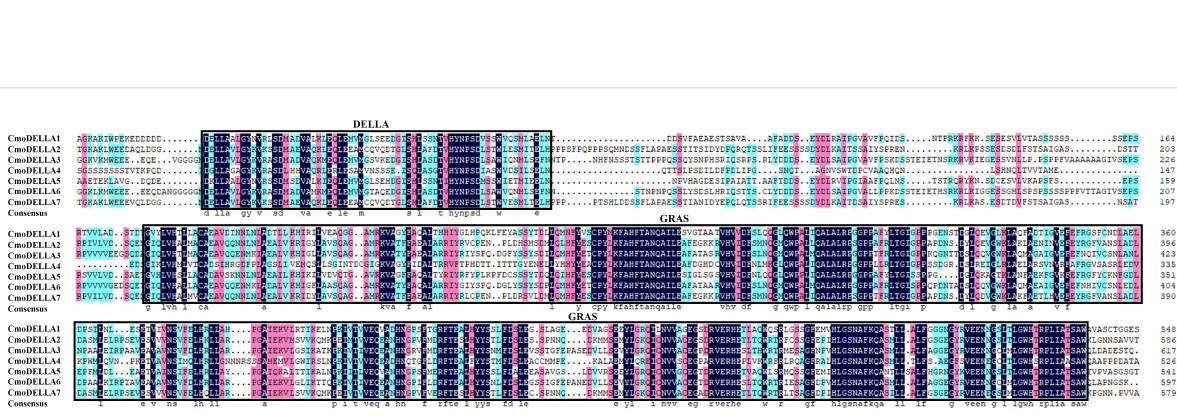
FIGURE 3 Amino acid sequence alignment of CmoDELLA proteins. The numbers on the right side of the sequence indicate the position of amino acid residues and the colors represent similarities in the protein sequences. The identical amino acid residues are shaded in black background, and the similar amino acid residues are shaded in the red and blue